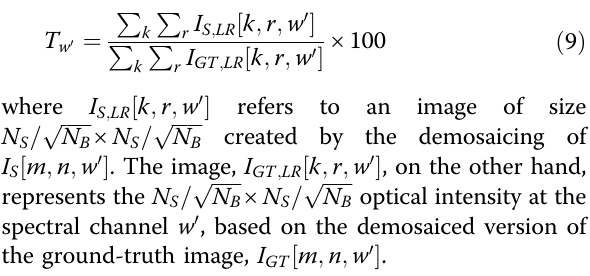
spectral fi lters repeating in space. The fabricated dif- fractive multispectral imager was trained using randomly generated intensity patterns, representing the amplitude transmission of the input objects. The 3D-printed blind test object is the letter ‘ U ’ designed based on a 5 × 5 binary image with each pixel corresponding to an area of 7 : 5 λ 1 ´ 7 : 5 λ 1 . The size of each diffractive feature on the 3D-printed diffractive layers shown in Fig. 6 equals ~0.5 mm × 0.5 mm. Each of the 3 fabricated diffractive surfaces processes the incoming waves based on 100 × 100 optimized diffractive features, extending over 62 : 5 λ 1 ´ 62 : 5 λ 1 . In the optical forward model of this diffractive network, all the axial distances between (1) the input FOV and the fi rst diffractive surface, (2) two successive diffractive surfaces and (3) the last diffractive layer and the output FOV were set to be 40 mm, i.e., ~50 λ . The variables h m and h b in Eq. 10 were taken to 1